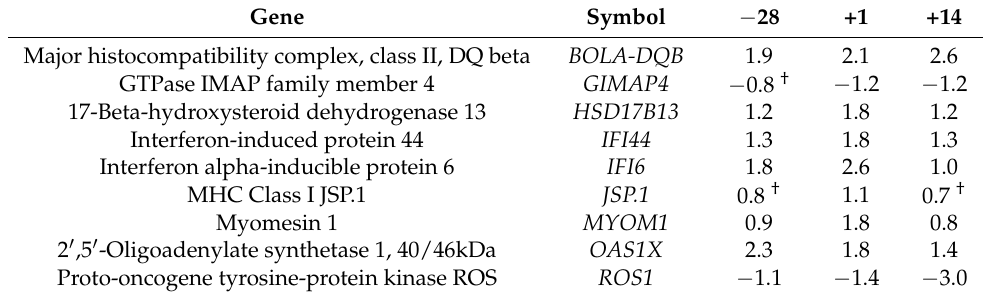
Table 4. Fold change 1 of genes with significant or marginal evidence of differential expression at all days relative to calving in liver samples from cows more or less resistant to lipid-related metabolic disorders 2